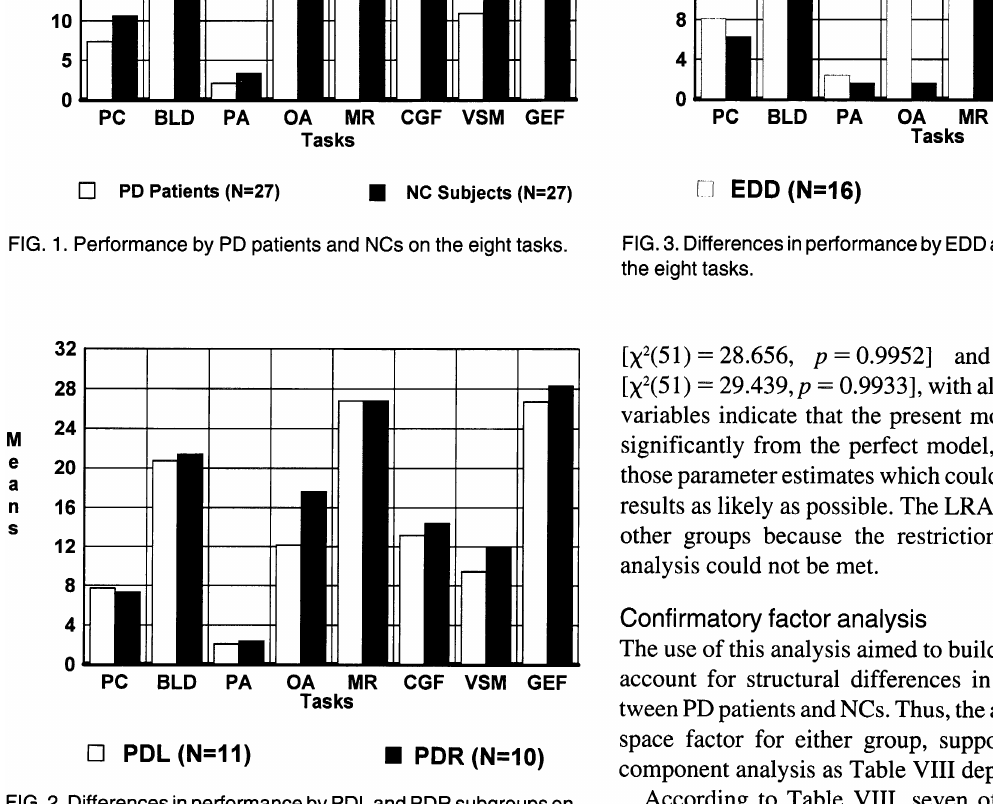
FIG. 2. Differences in performance by PDL and PDR subgroups on the eight tasks.